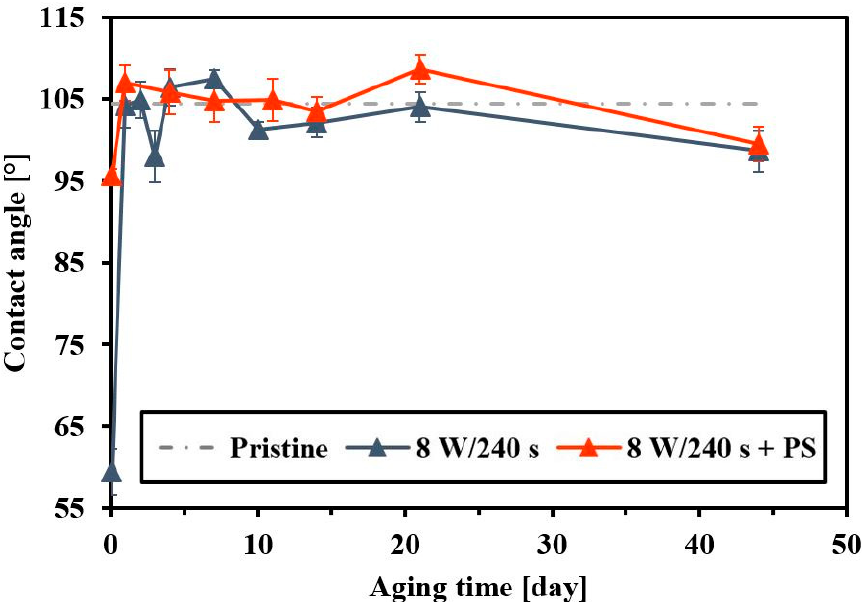
Figure 6. Contact angles and aging of pristine fluorinated ethylene propylene (FEP), plasma-treated FEP (8 W/240 s), and subsequently coated with a polystyrene (PS) layer (8 W/240 s + PS).